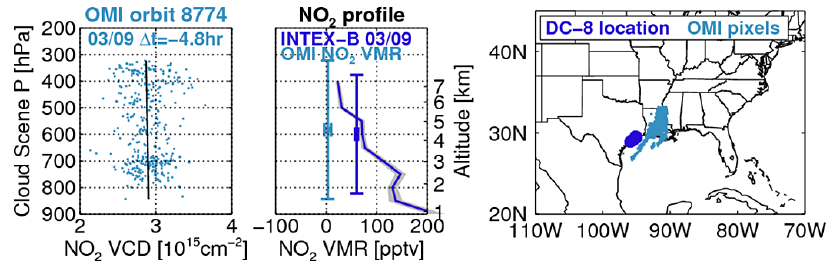
Figure B1. Similar to Fig. 5, but showing a case with a discrepancy between satellite and aircraft measurements, possibly due to poor collocation, with INTEX-B measurements near Houston, Texas, US, and OMI measurements over Louisiana, US.